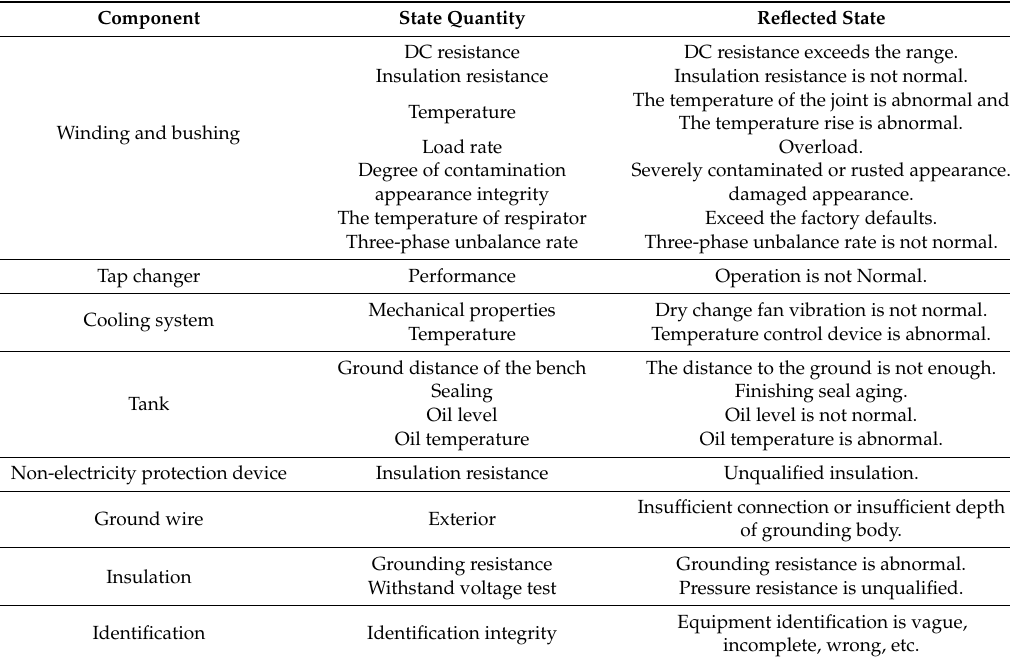
Table 1. Typical state quantity of a distribution transformer.